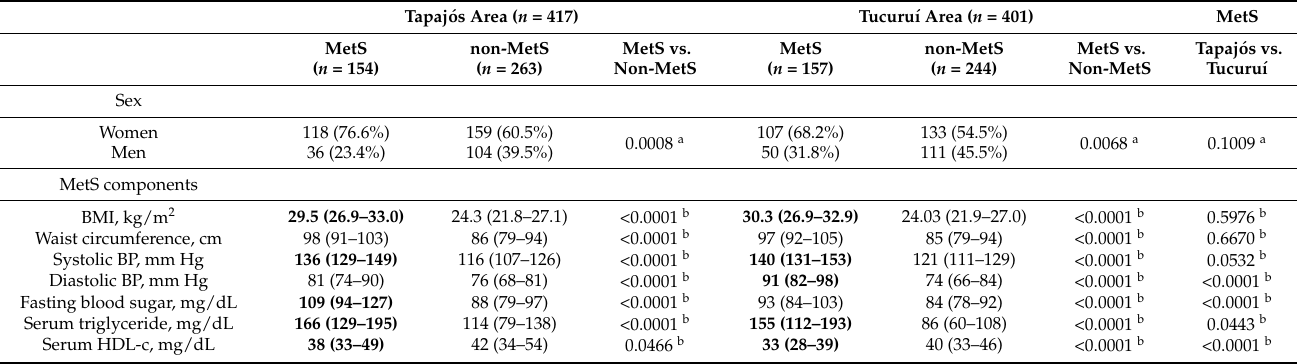
Abbreviations: BMI, body mass index (calculated as weight in kilograms divided by the square of height in meters); BP, blood